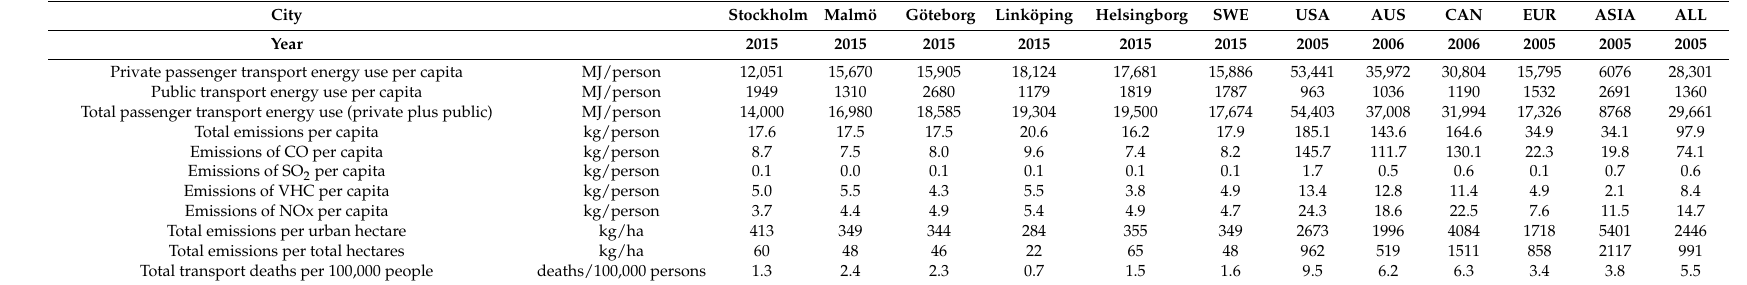
Table 9. Energy, emissions, and transport fatalities in Swedish and international